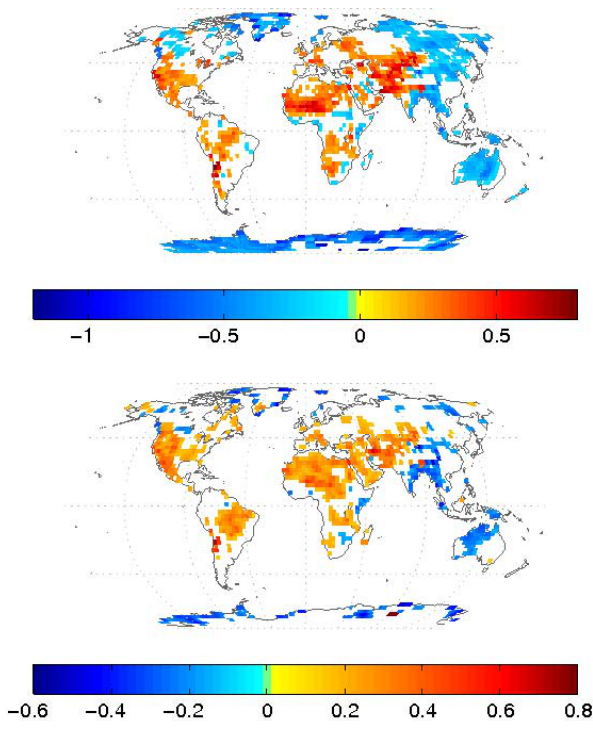
Fig. 8. Statistically significant (95% confidence interval) trends of the normalised anomaly of (top) energy balance evaporation E r and (bottom) Penman potential evaporation E p , at each 2.5 ◦ × 2.5 ◦ cell. Units are decade − 1